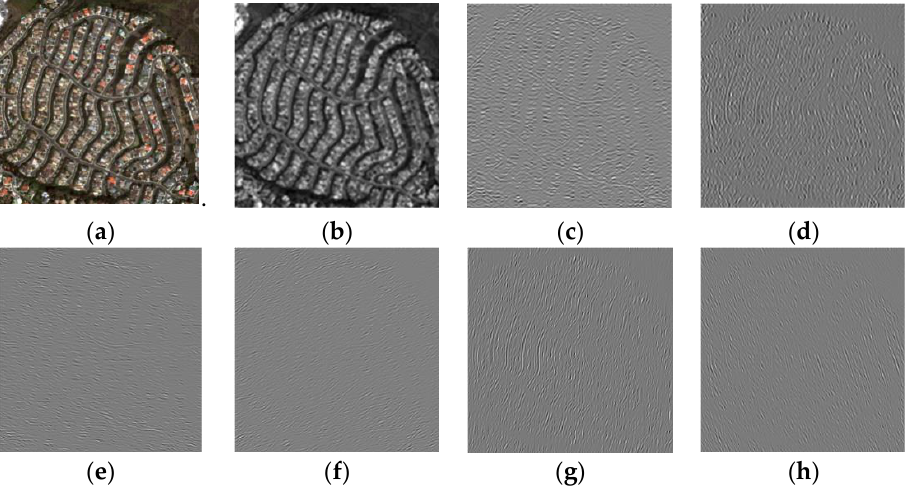
( d )High frequency sub-band first scale direction two. ( e ) High frequency sub-band second scale direction one. ( f ) High frequency sub-band second scale direction two. ( g ) High frequency sub-band second scale direction three. ( h ) High frequency sub-band second scale direction four.